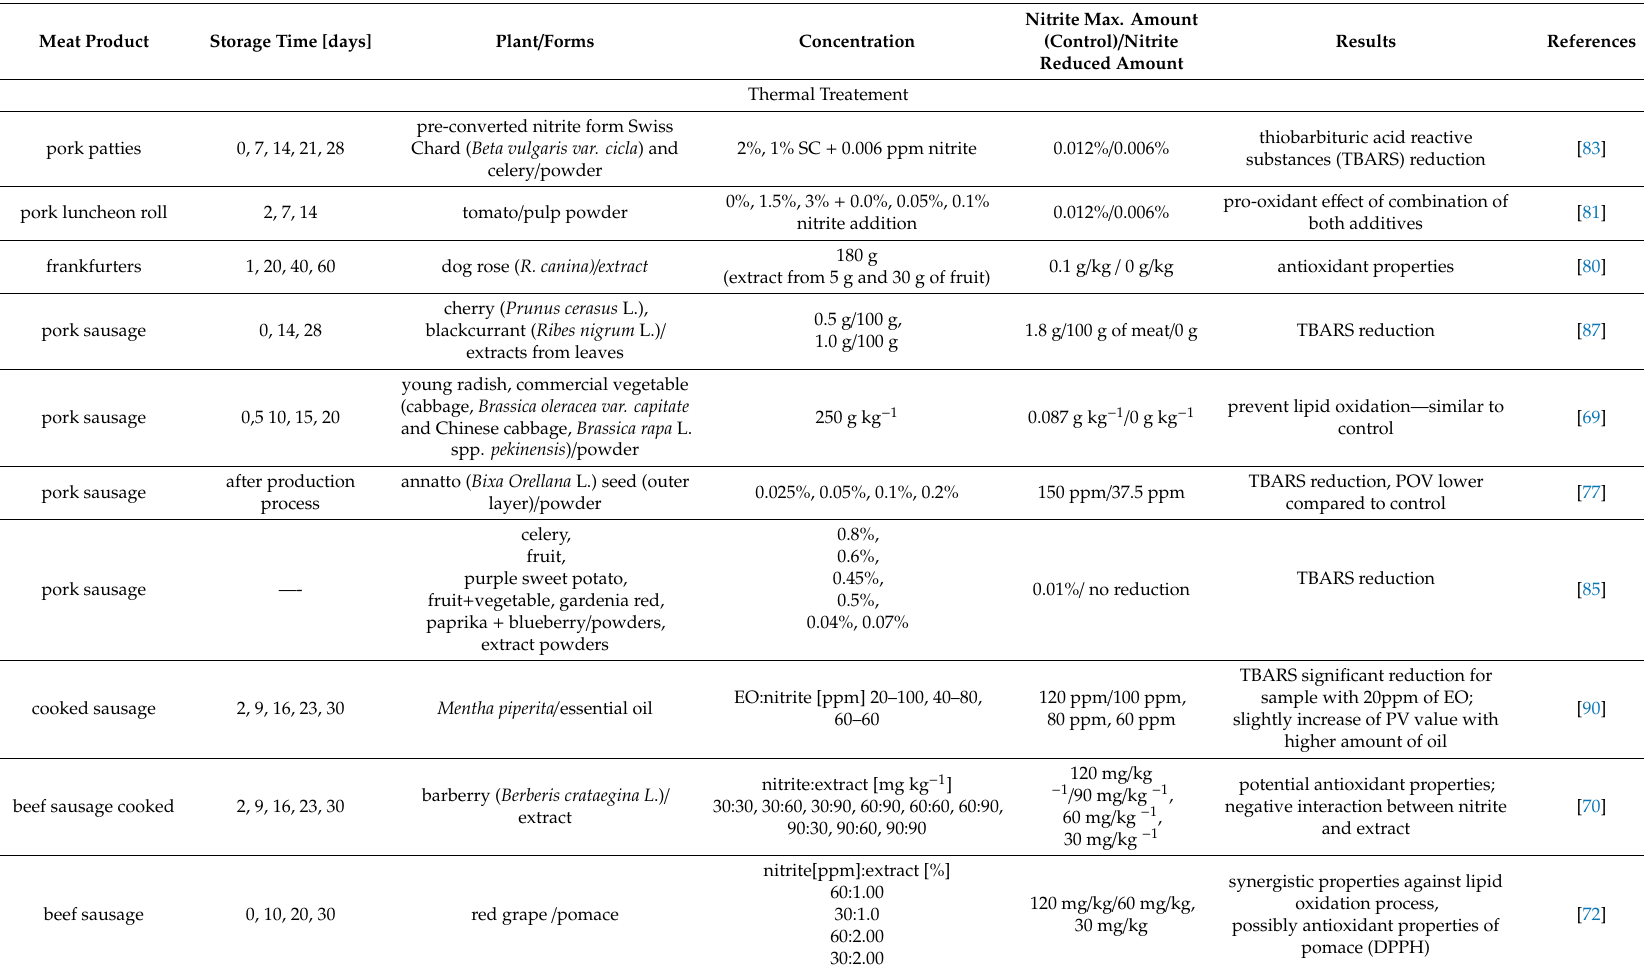
Table 3. Application of plant extracts as natural antioxidants in meat products with a reduced quantity of